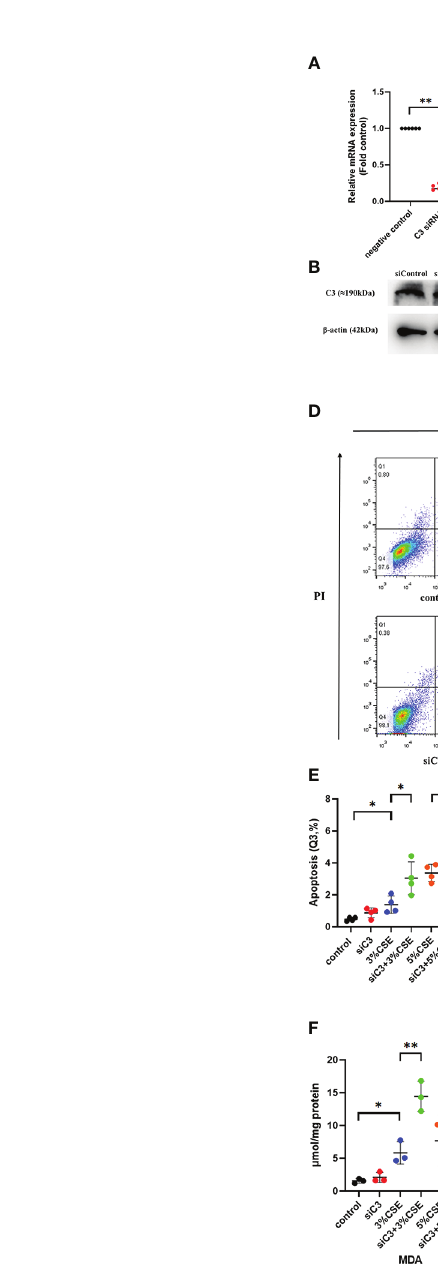
FIGURE 4 C3 inhibition enhances CSE-induced oxidative stress and apoptosis in AECs. 16HBE cells were transfected with siControl or siRNA targeting human C3 (siC3). (A) C3 siRNA reduced C3 mRNA level by 80%. (B) Representative immunoblots showing knockdown of C3 proteins using C3- speci fi c siRNA. (C) C3 siRNA reduced the C3 protein levels by approximately 70%. (D) Cells were left untreated (control) or treated with CSE (3% or 5%) for 24 h. The proportion of apoptotic cells (Q3), secondary necrotic cells (Q2) and primary necrotic cells(Q1) were determined by annexin (x-axis) and propidium iodide (PI, y-axis) staining using fl ow cytometry. (E) Representative analysis plot of cell apoptosis, secondary necrosis and primary necrosis. * P < 0.05. (F-H) MDA assay kits were used to measure MDA content, SOD assay kits were used to measure SOD content, and the DCFH-DA method was used to measure ROS production. Data are expressed as mean ± S.D. N ≥ 3 independent experiments. * P < 0.05, ** P < 0.01, ns, no signi fi